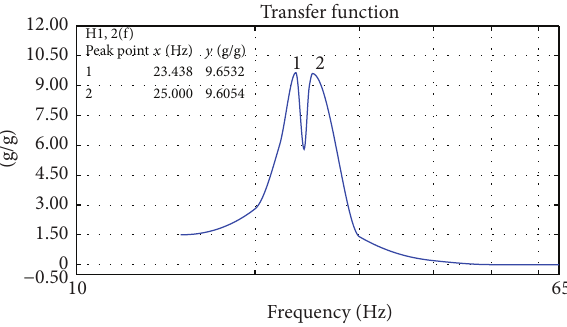
Figure 16: Bifurcation of natural frequency when fatigue cracks were